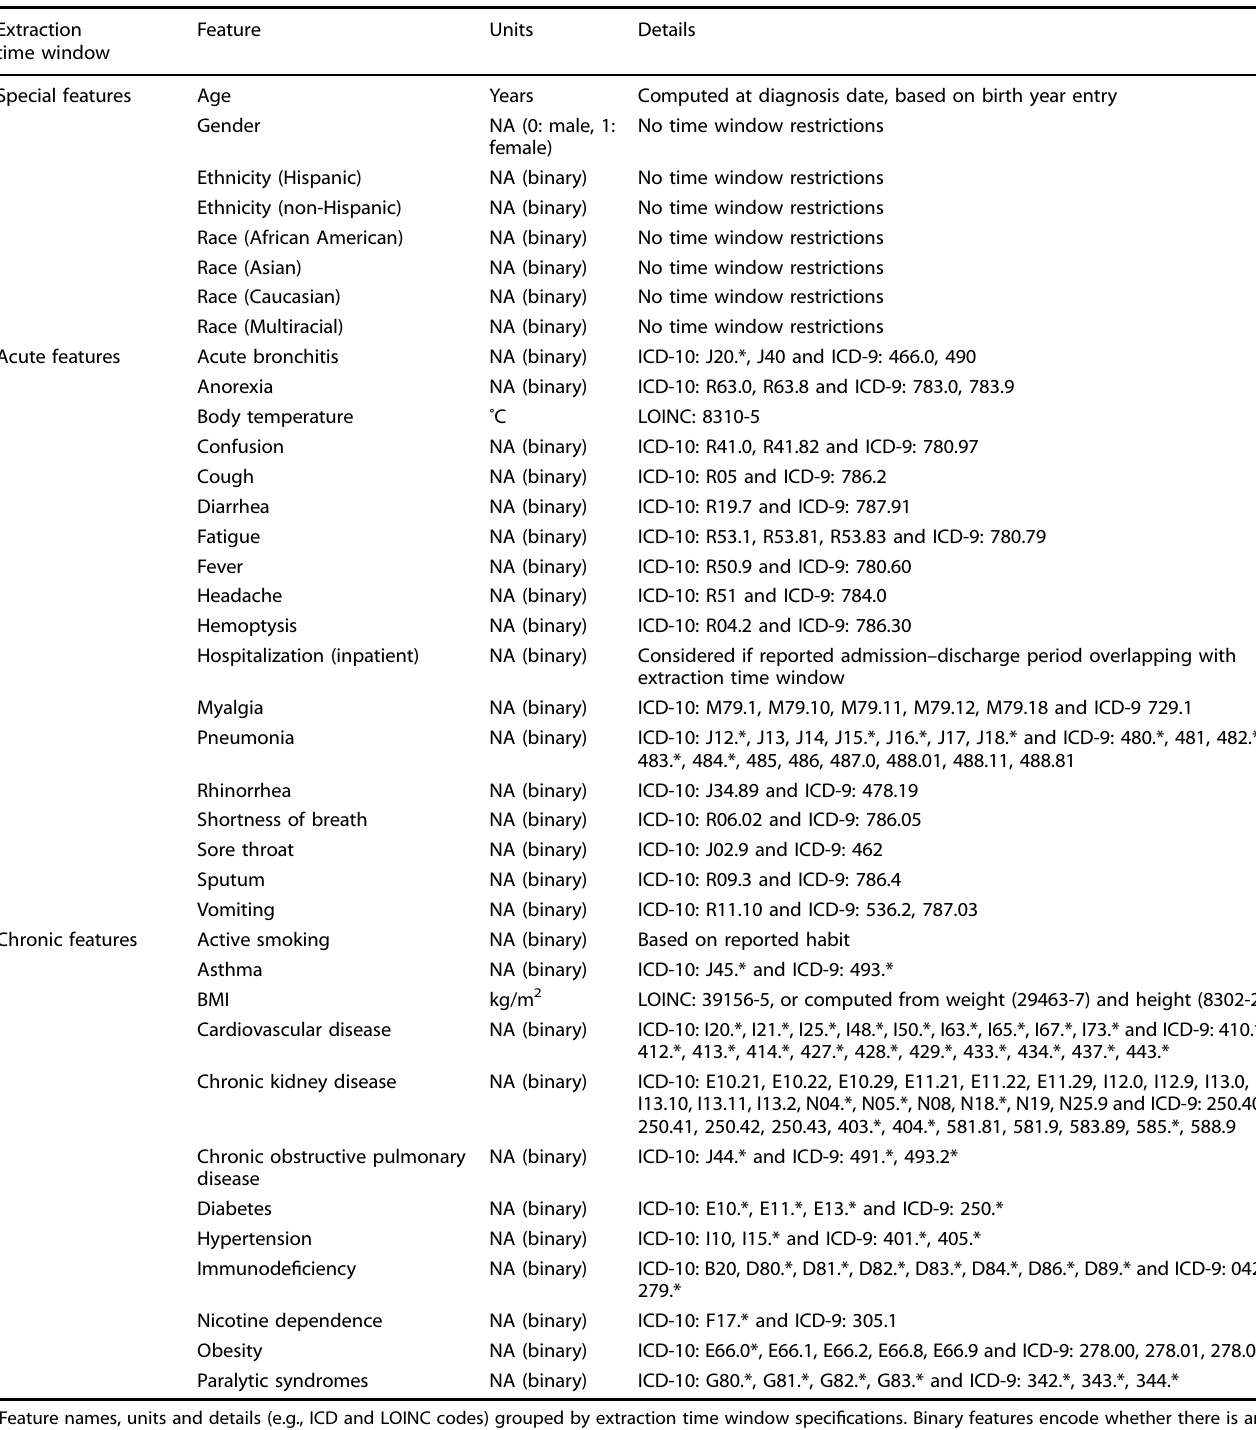
Table 1. Feature de fi